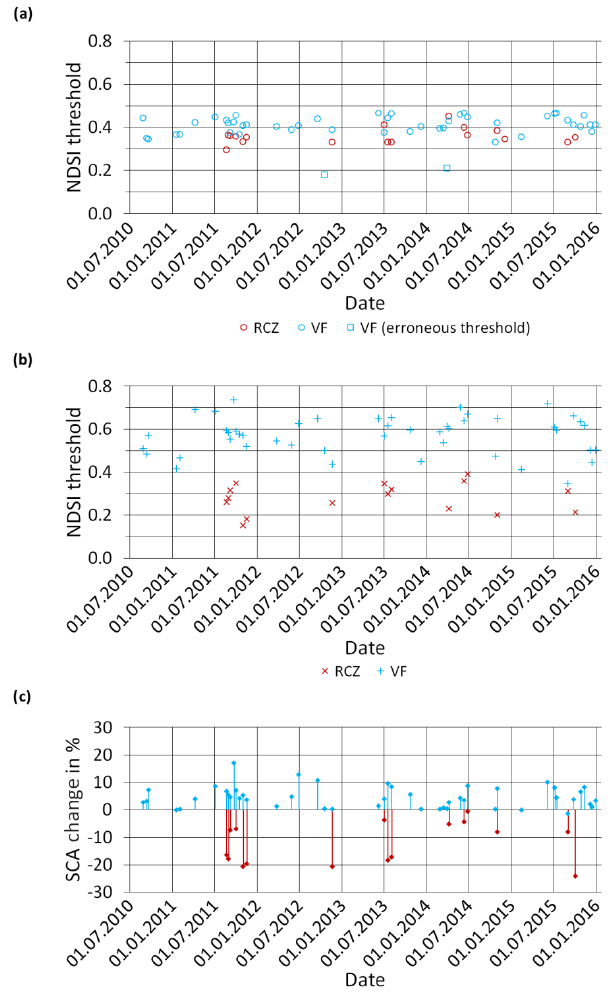
Figure 7. The figure displays in (a) the complete time series of ad- justed NDSI thresholds using the Otsu segmentation method (cir- cles, erroneous thresholds as squares) at RCZ (red) and VF (blue) and depicts in (b) the camera-calibrated NDSI thresholds at these two sites utilizing ground-based photographs as in situ measure- ments (blue pluses for VF and red crosses for RCZ). Relative SCA changes at RCZ and VF resulting from the application of the stan- dard instead of the camera-calibrated reference NDSI threshold are shown in (c) .